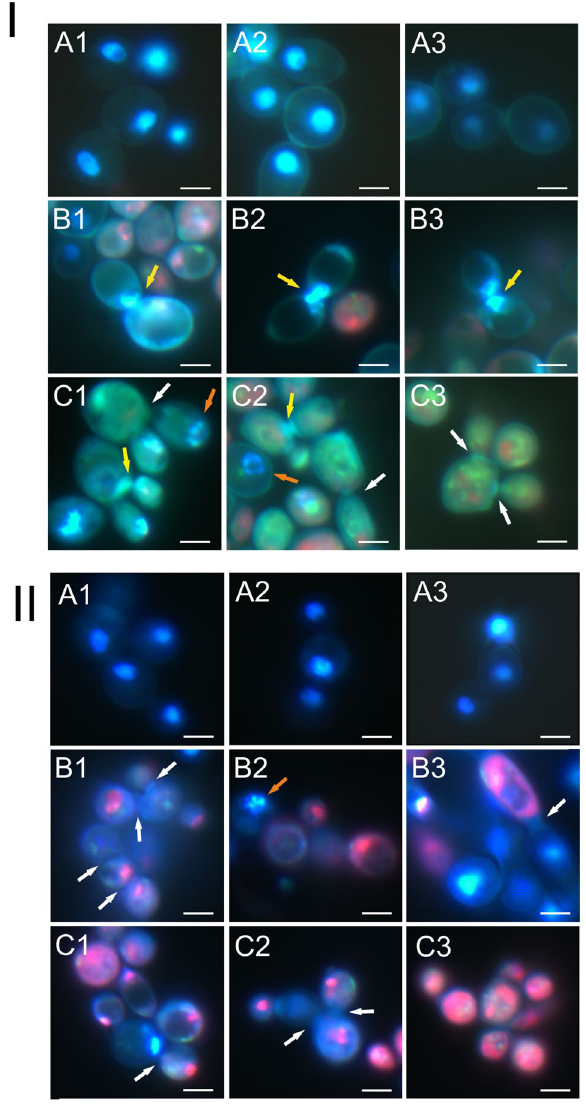
Figure 4. C. albicans cells after the incubation with Venetin-1 and fluconazole stained with a mixture of Hoechst 33342 and Propidium iodide dyes; I- A1–A3—control culture cells; B1–B3—cells after the incubation with Venetin-1 at 50 µg mL −1 ; C1–C3—with Venetin-1 at 100 µg mL -1 ; II- A1–A3—control culture cells, B1– B3—cells after the incubation with fluconazole at 10 µg mL −1 , C1–C3—with fluconazole at 20 µg mL -1 . The yellow arrows indicate non-separated genetic material of the cells after cell division; the white arrows indicate incomplete separation of cells after division; orange arrows show apoptotic cells. The scale bar represents 5